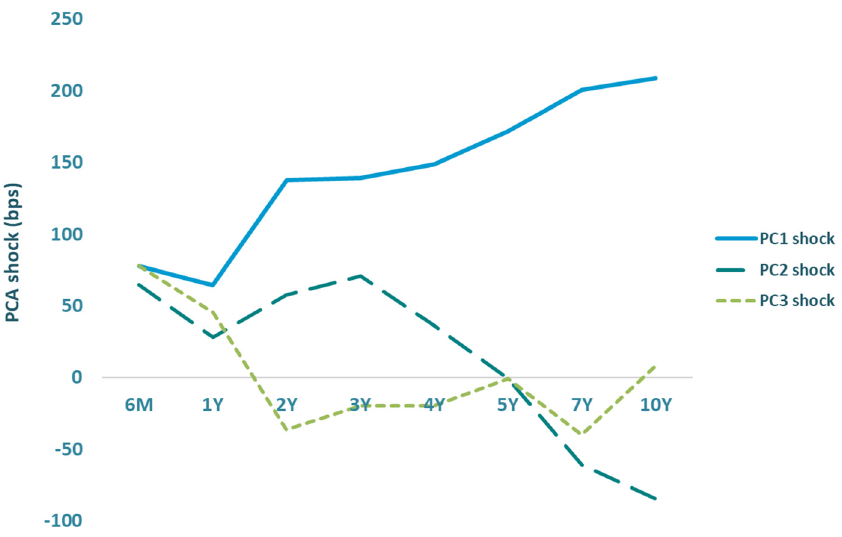
Figure 15. One-standard-deviation weekly yield curve shocks corresponding to each principal component on 25 March 2022. Source: Bloomberg yields, own computation.